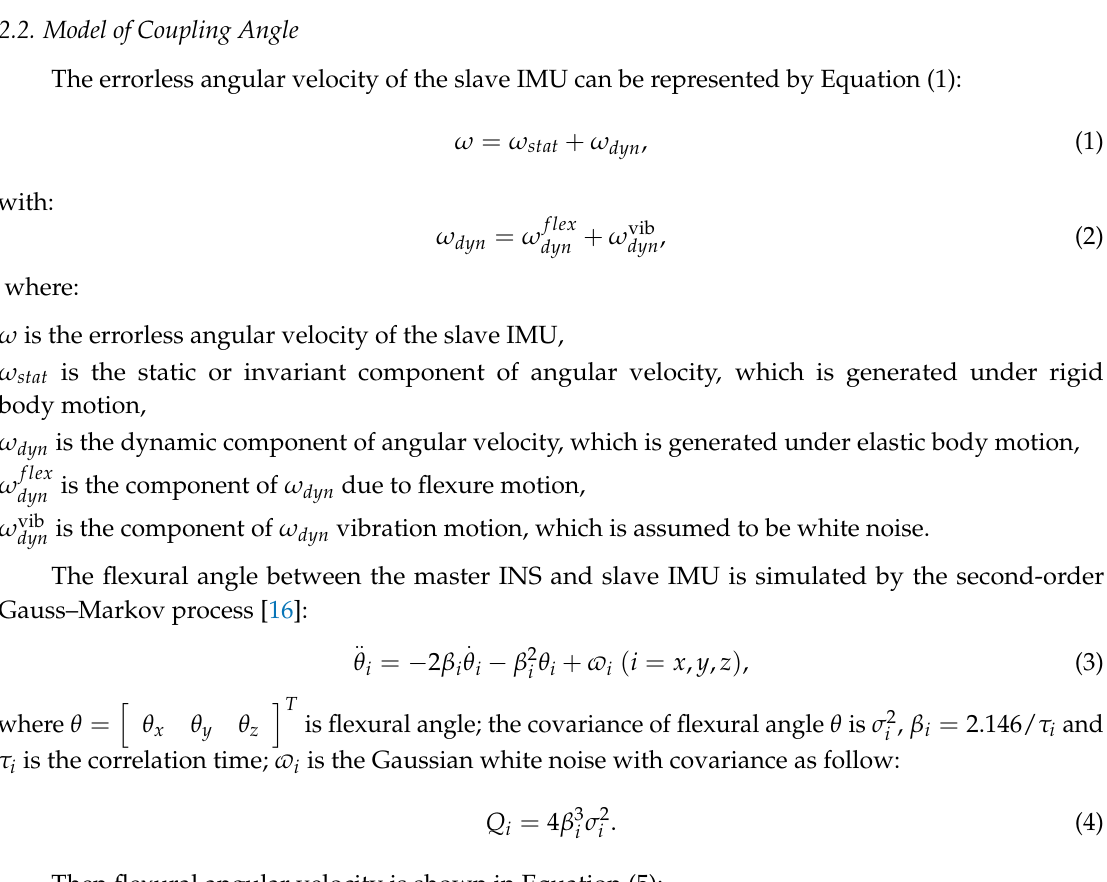
Figure 1. Sensor location.